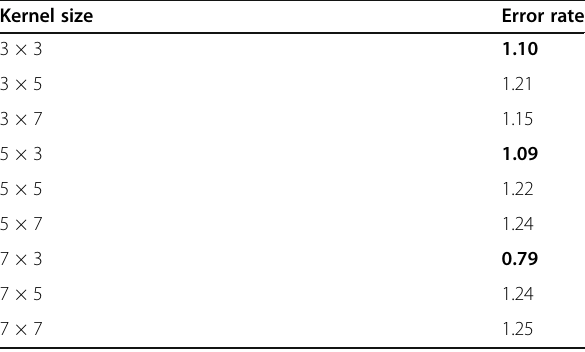
Table 7 Comparison of different kernel size Kernel size